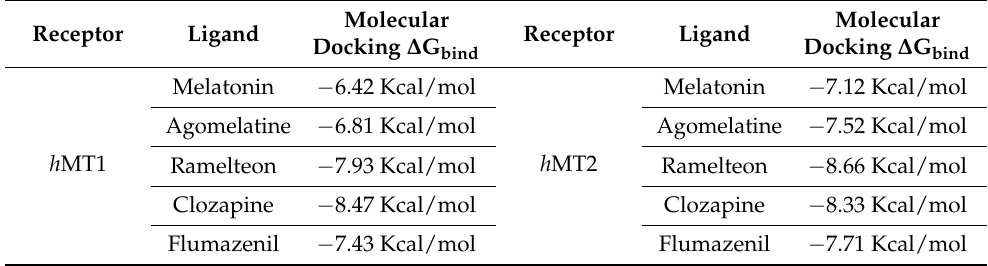
Table 2. Binding energies of best-scored compounds compared to melatonin and its agonist agomela- tine